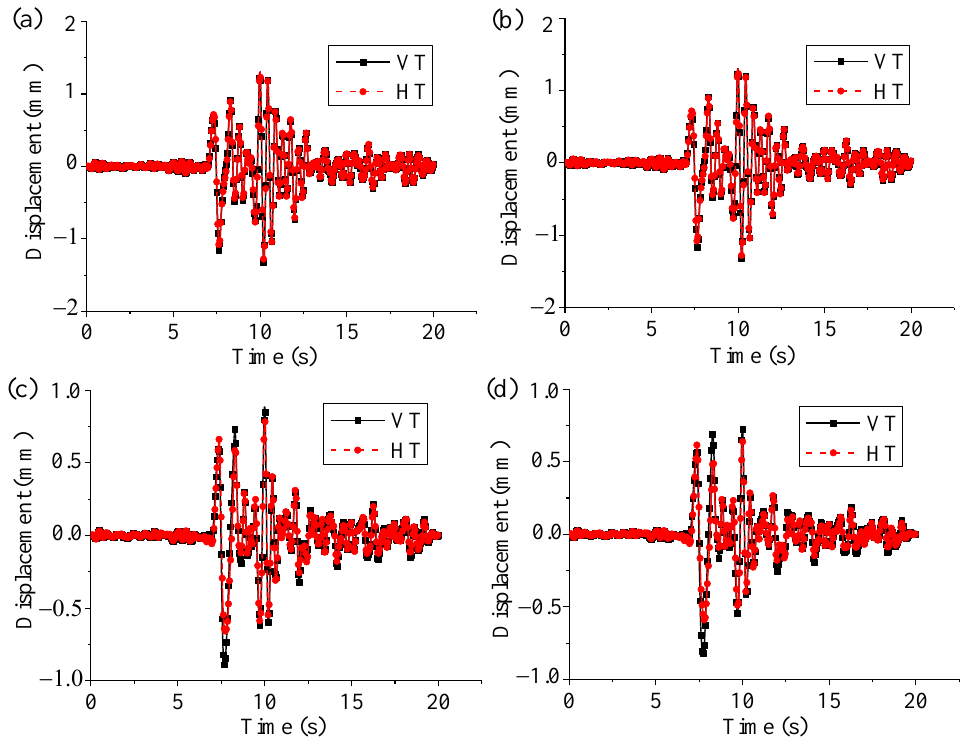
Figure 7. The time-domain displacements of different models due to Tianjin wave: ( a ) Model A; ( b ) Model B; ( c ) Model C; ( d ) Model D.